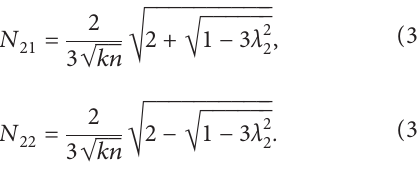
Figure 3: Time-history curves of the nonlinear energy sink λ